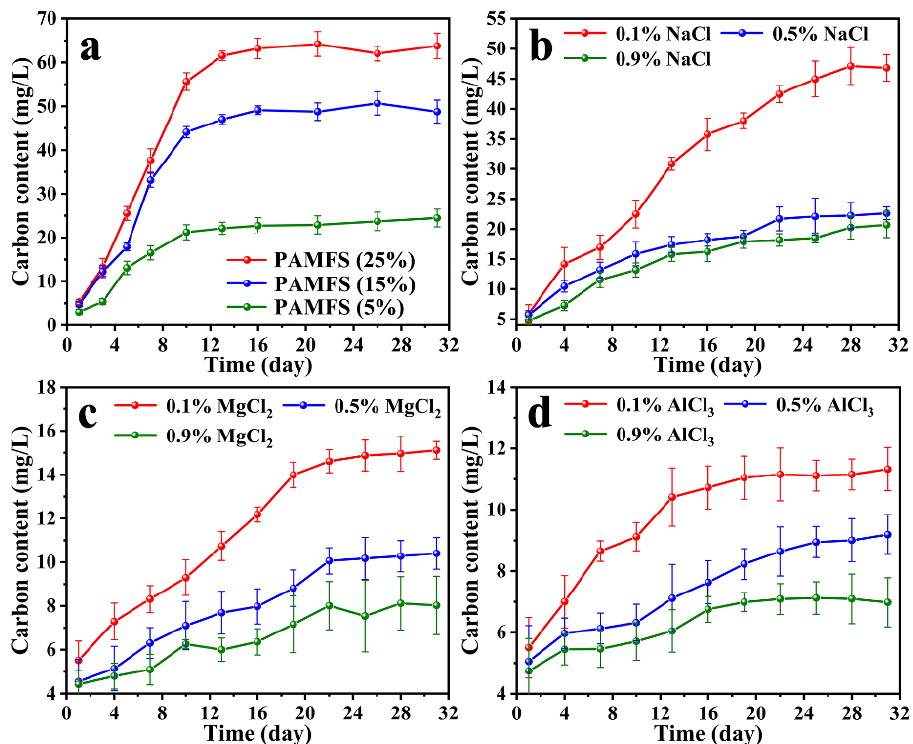
Figure 6. FA slow release of PAMFS in distilled water ( a ), FA slow release of PAMFS (15 wt%) in NaCl salt solutions ( b ), MgCl 2 salt solutions ( c ) and AlCl 3 salt solutions ( d ).